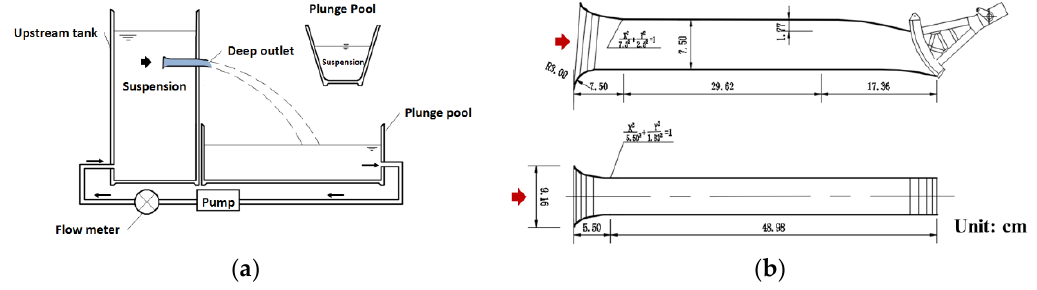
Figure 1. Schematic diagram of the experimental ( a ) re-circulating flume; and ( b ) deep outlet.